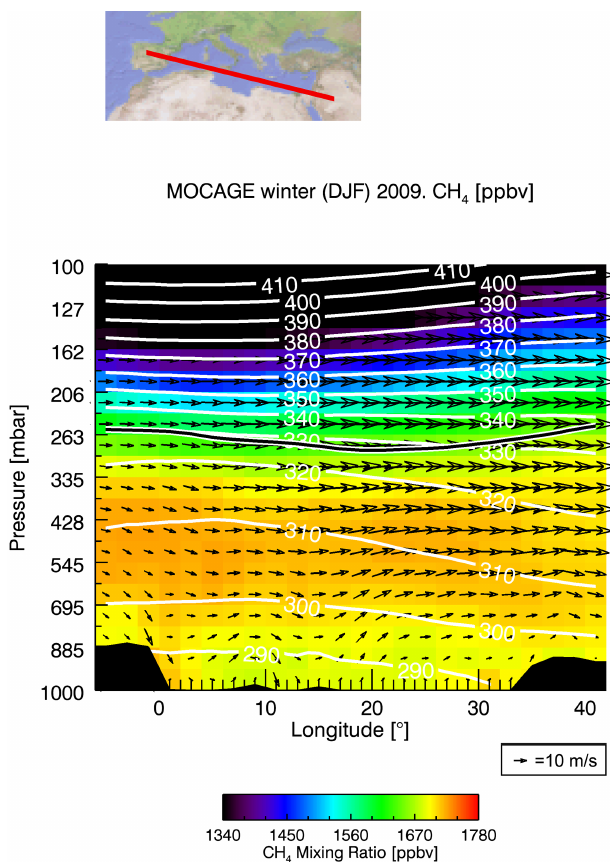
Figure 4. As Fig. 2, but for winter (DJF) 2009.